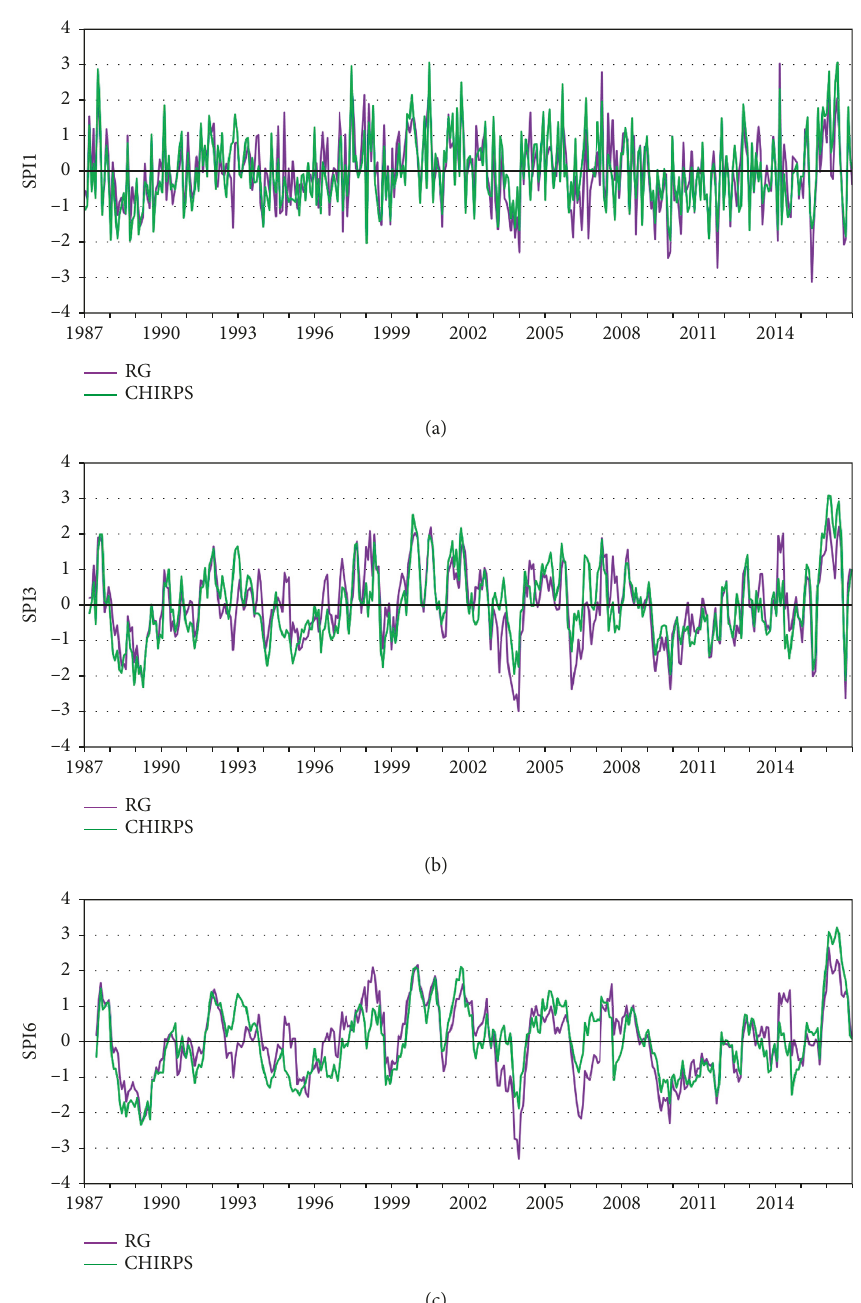
Figure 3: SPI time series for the WS region based on CHIRPS and rain gauges (RG) during 1987–2016: (a) SPI1, (b) SPI3, and (c)